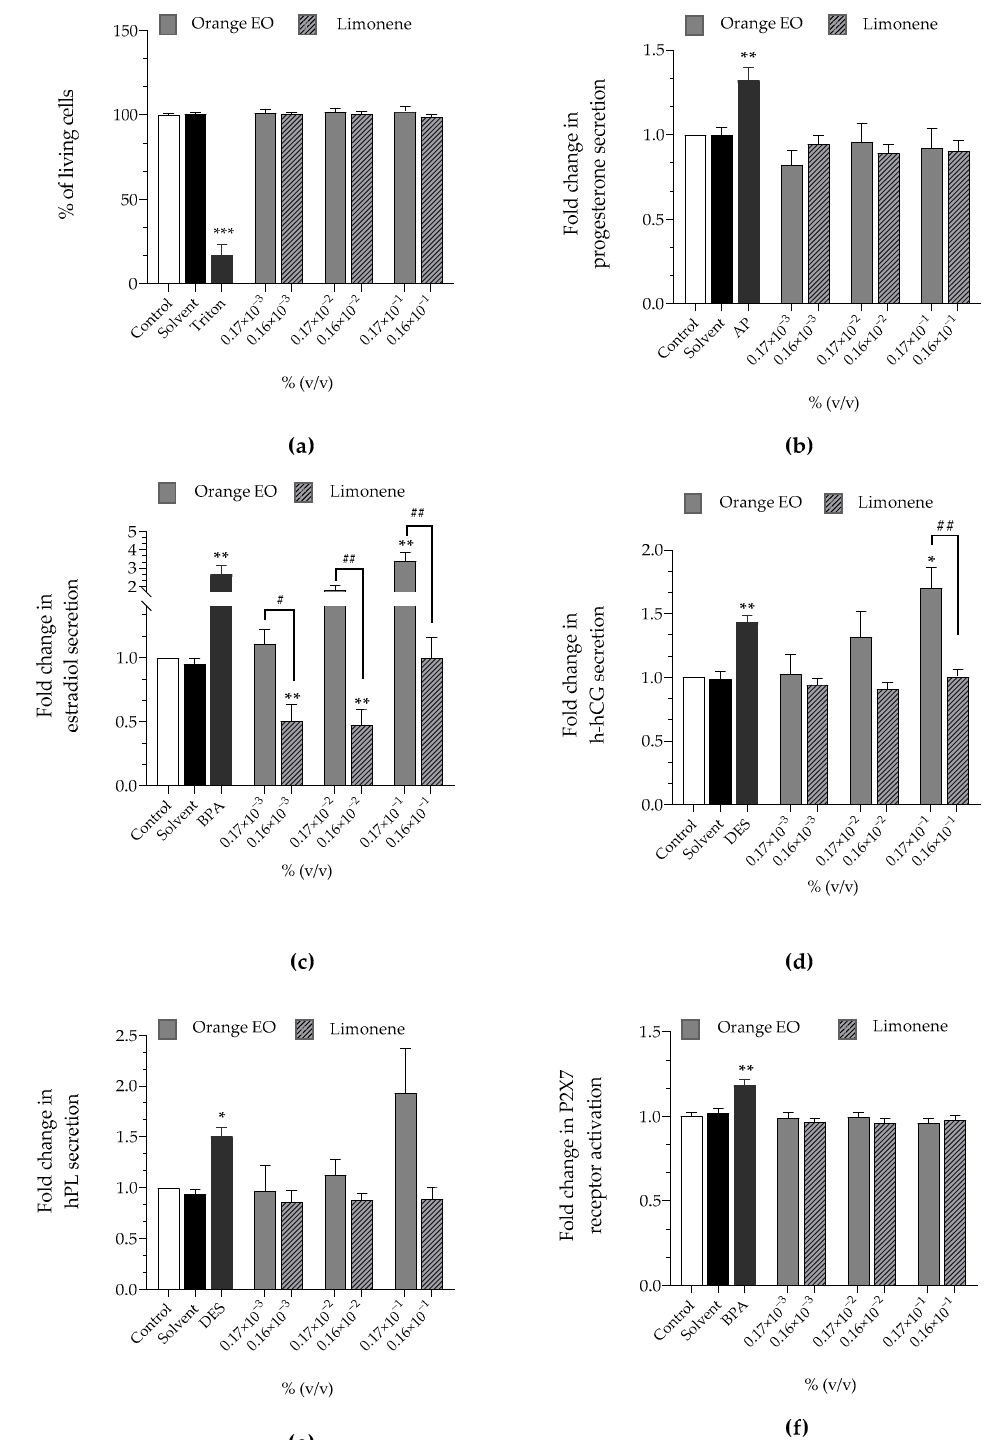
Figure 2. Effects of orange EO and limonene on ( a ) cell viability (Alamar Blue assay), on released hormones: ( b ) progesterone ( c ) estradiol, ( d ) h-hCG, ( e ) hPL and on ( f ) P2X7 receptor activation (YO-PRO-1 assay) were evaluated, after incubation of JEG-Tox cells for 72 h. Triton ® X-100 at 0.016%, bisphenol A (BPA) at 20 µ M, 4-tert-amylphenol (AP) at 10 µ M and diethylstilbestrol (DES) at 3.75 µ M are used as positive controls. The significance thresholds were * p < 0.1, ** p < 0.01, *** p < 0.001, # p <0.1, and ## p <0.01.